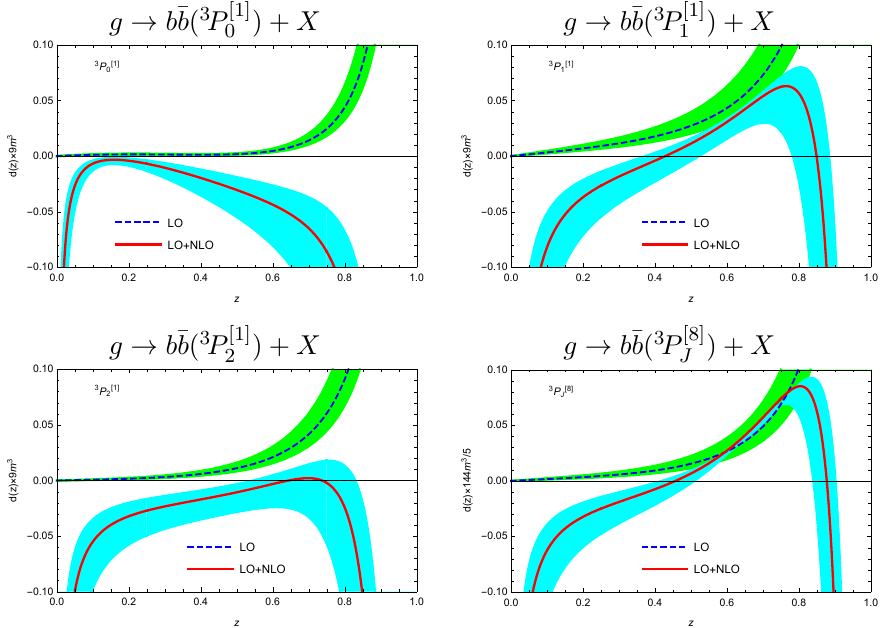
Figure 6 . SDCs of the fragmentation functions of g → b ¯ b ( 3 P [1 , 8] dashed line is for d LO ( z ) × c [1 , 8] , and the solid line is for ( d LO ( z ) + d NLO ( z )) × c [1 , 8] , with scale choices µ r = µ 0 = µ Λ = 2 m b , c [1] = 9 m 5 bands are obtained by varying the renormalization scale µ r by a factor of